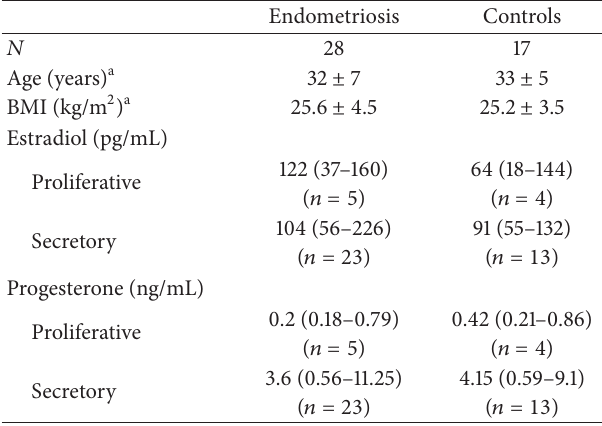
Table 1: Characteristics of women with endometriosis and normal pelvis